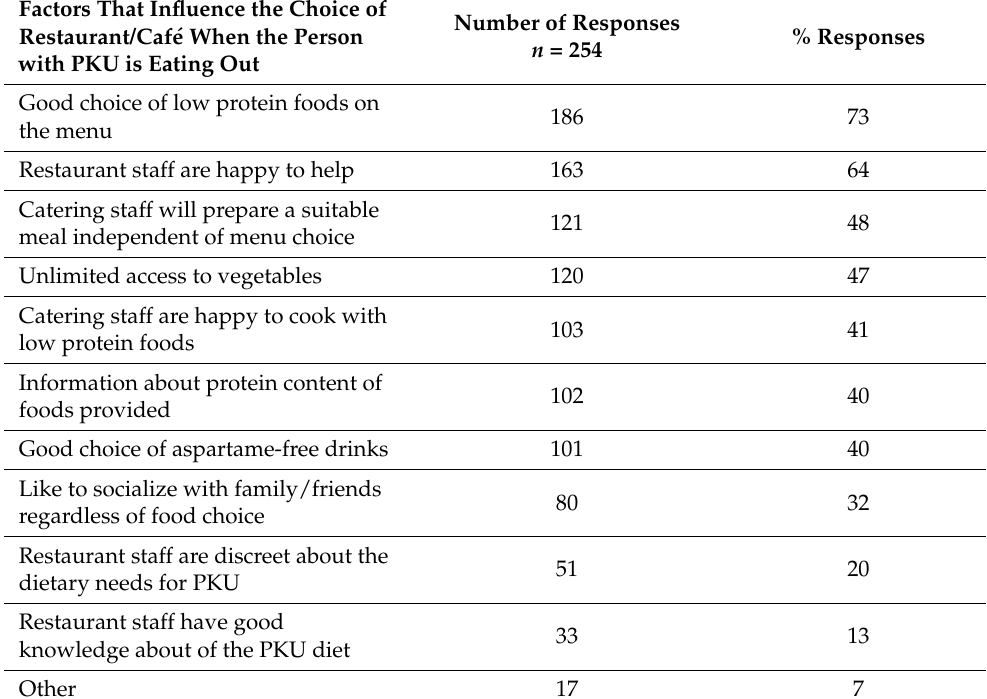
Table 2. Factors that influence the choice of restaurant/caf é when the person with PKU is eating out ( n = 254)